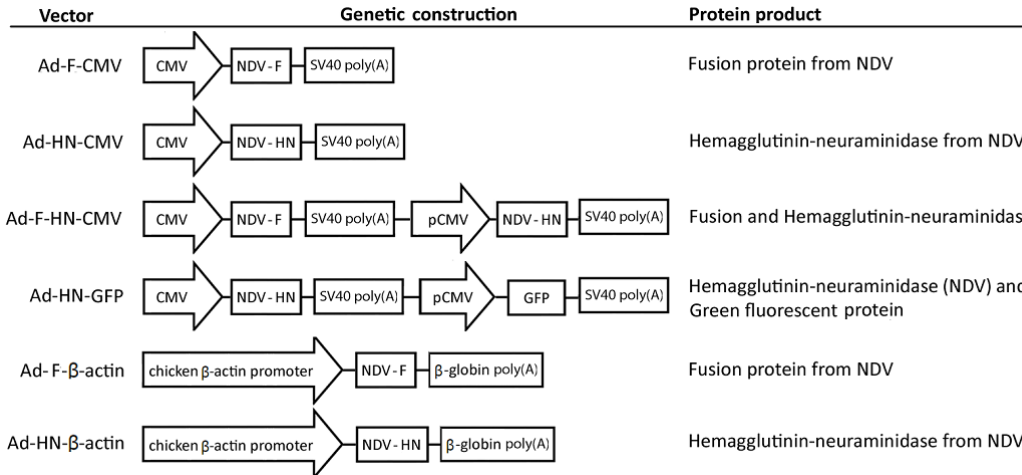
Figure 1. Nonreplicating chicken codon-optimized recombinant adenovirus constructions as vaccine candidates against Newcastle Disease virus (NDV): The schematic representation of the adenoviral constructs shows the regulatory regions for the control of expression and the fusion and hemagglutinin-neuraminidase proteins of NDV. The expression of the foreign antigens is driven either by a fragment of the human Cytomegalovirus (CMV) enhancer / promoter or by the avian β -actin promoter, as indicated. The adenoviral vectors have been designed to carry one or two (head-to-tail oriented) expression units for the individual expression or the co-expression of the NDV antigens. One of the constructs carries both the hemagglutinin-neuraminidase protein and the green fluorescent protein for monitoring and quantification during the process development steps implemented at different scales.